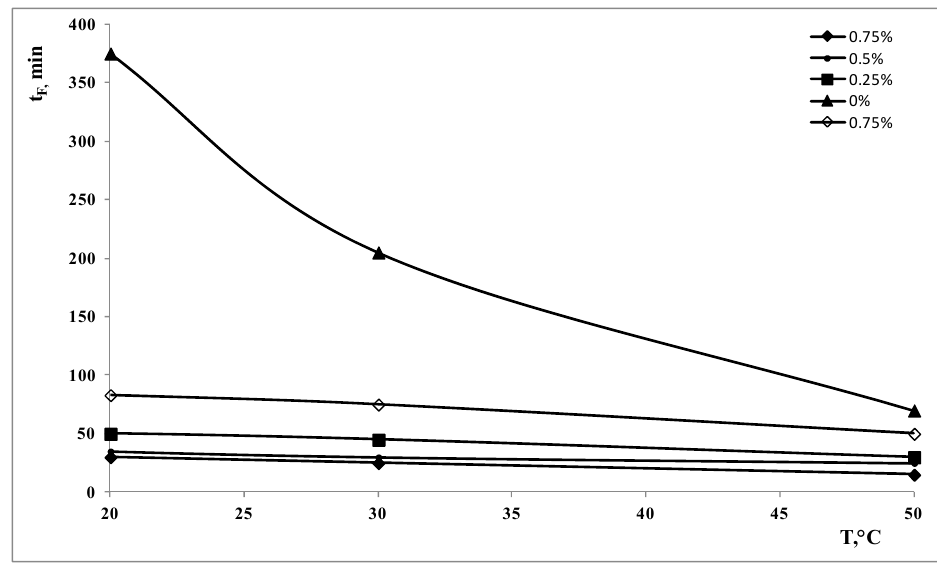
Figure 4. Time necessary to completely remove all the non ‐ polymeric components, t f , at the two values of the power as a function of the treatment temperature and different NH 3 concentration. Full symbols: 120 W, empty symbols: 50 W.